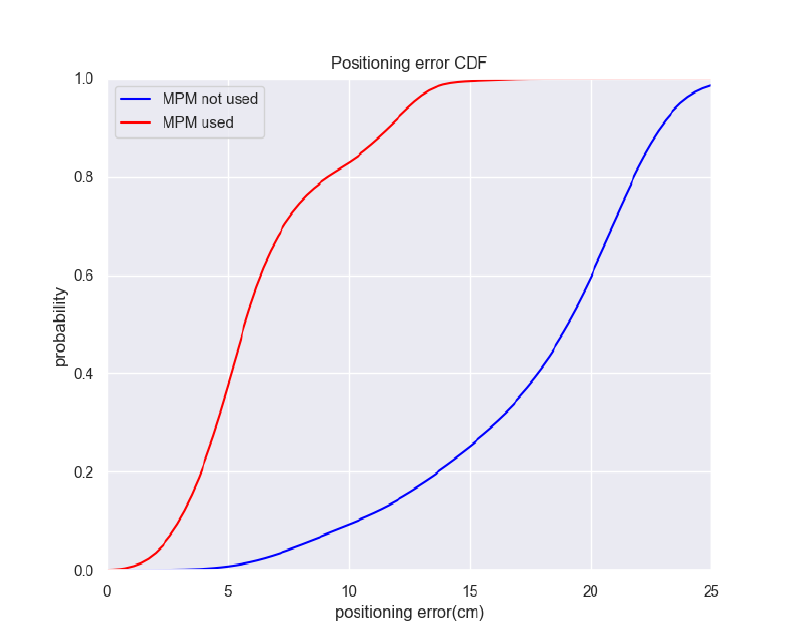
Figure 11. positioning error CDF in experiment area.